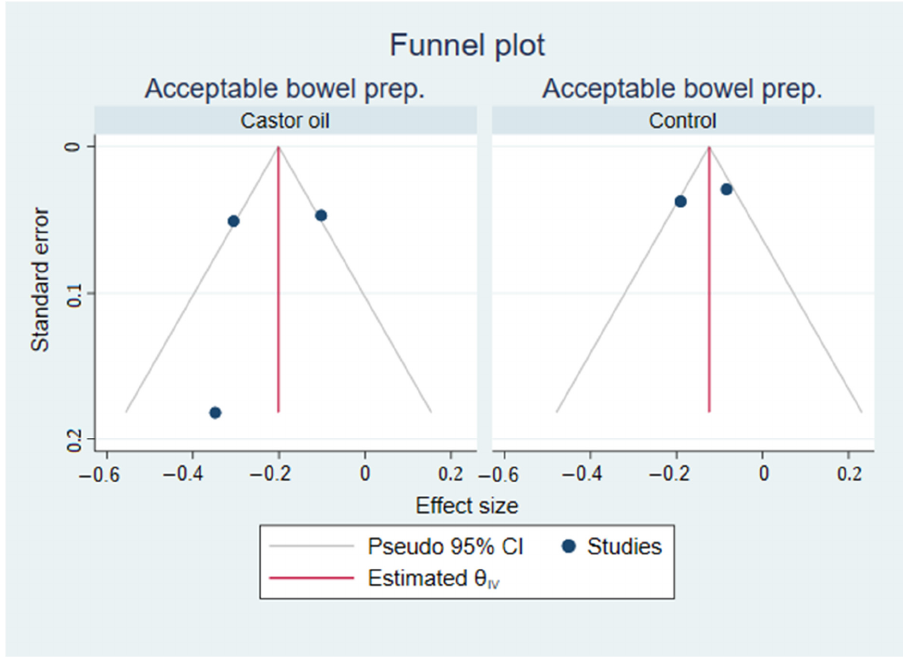
Figure A2. Funnel plots from Egger’s tests visualizing the symmetry of the effect sizes within each sub-analysis of acceptable bowel preparation rate from a meta-analysis on colon capsule endoscopy using castor oil in the bowel preparation regimen.